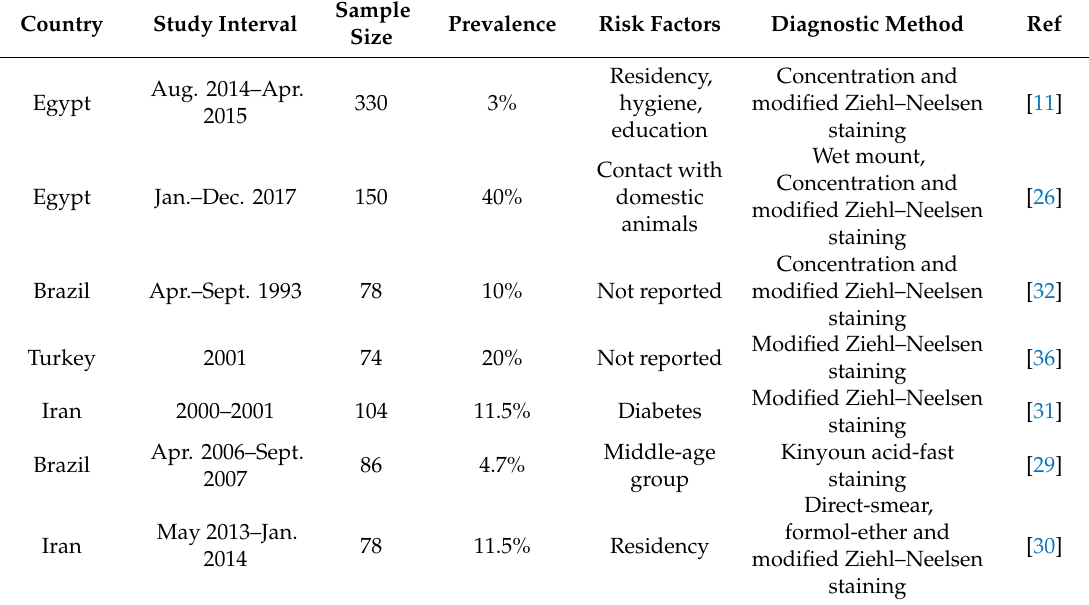
Table 2. Cryptosporidiosis among hemodialysis patients